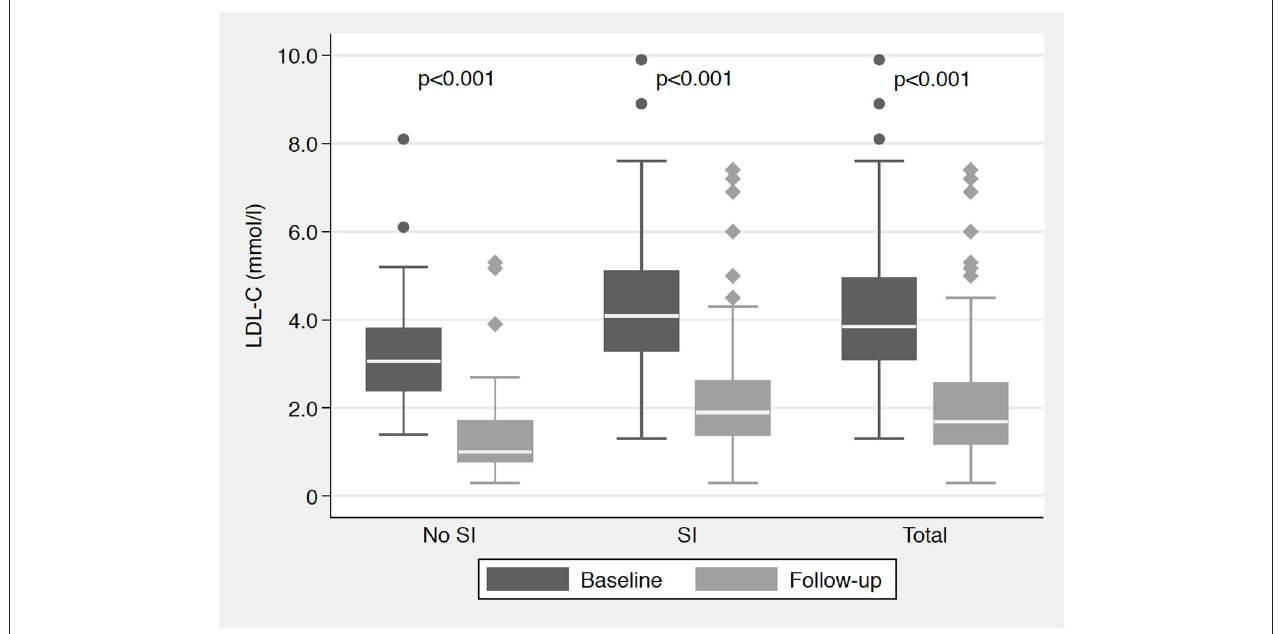
FIGURE 1 | Median (IQR) LDL-C (mmol/l) at baseline and follow-up visit according to the presence of statin intolerance. IQR, interquartile range; LDL-C, low-density lipoprotein cholesterol; SI, statin intolerance; all p -values for the comparisons of LDL-C at follow-up vs.